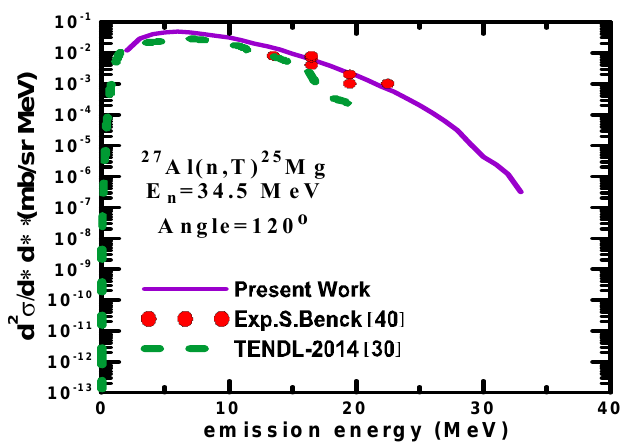
Fig. 9: The double differential cross sections calculated in the present work as a function of emission energy and different emission angle 120 0 for the reaction 27 Al+n and emitted triton at 34.5 MeV compared with experimental data [40] other theoretical results TENDL [30].